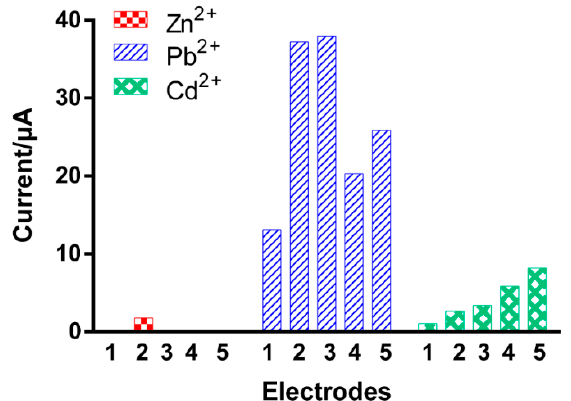
Figure 5. Effects of different Bi-chitosan nanocomposite preparation conditions on the detection of heavy metal ions. Electrode #1: − 100 mA/cm 2 for 30 s, Electrode #2: − 100 mA/cm 2 for 60 s, Electrode #3: − 100 mA/cm 2 for 120 s, Electrode #4: − 100 mA/cm 2 for 180s, Electrode #5: − 200 mA/cm 2 for 120 s.